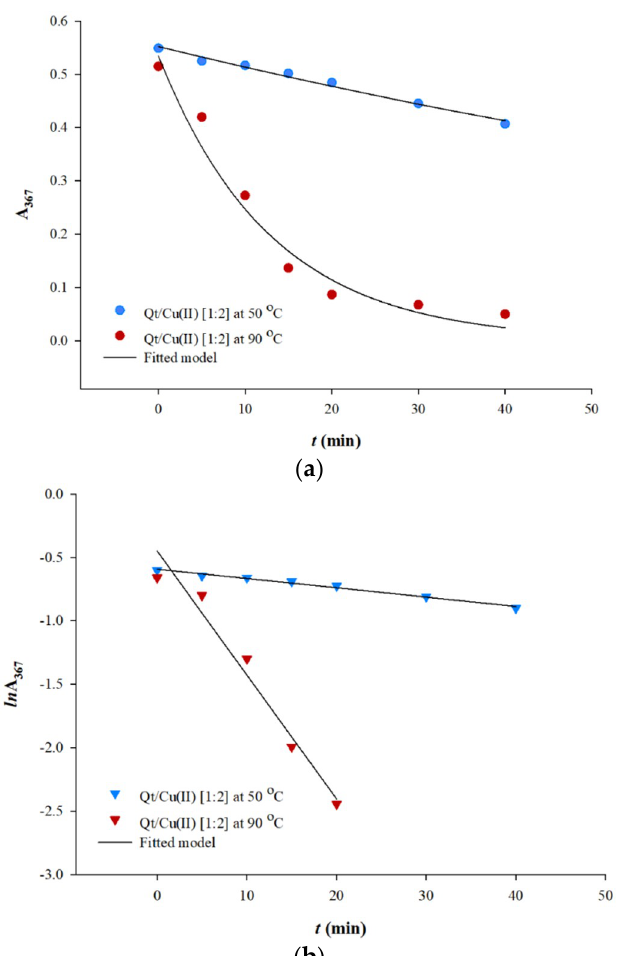
Figure 2. Kinetics of quercetin oxidation (33.3 µM) at pH 7 in the presence of 66.6 µM of Cu 2+ ( a ) and verification of pseudo first‐order kinetics shown by linear plots ( b ). A plot of ln A 367( t ) against t is a straight line with the slope equal to − k (Figure 2b). The half‐life ( t ½ ) of quercetin could then be calculated: